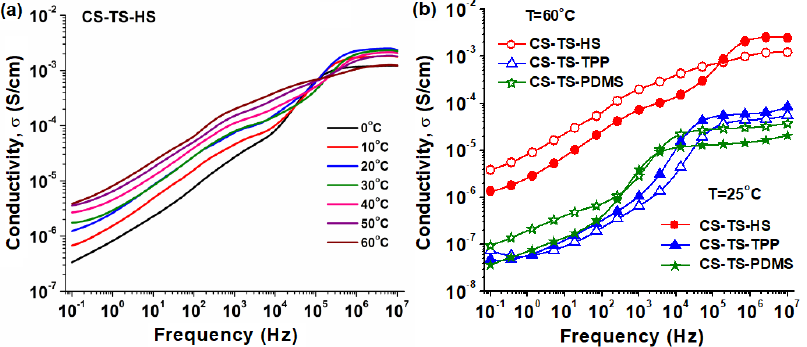
Figure 8. Evolution of conductivity with frequency at different temperatures for hydrated samples: ( a ) CS-TS-HS membrane, ( b ) comparison of conductivity behavior of all cross-linked membranes. The comparative σ ( f ) spectra of hydrated membranes from Figure 8b and the conductivity values collected in Table 2 reveal that both the low frequency and the high frequency independent frequency plateaus are different in magnitude and their enlargement is depending on membrane composition, water content and temperature. The conductivity of hydrated CS-TS-HS membrane is two orders